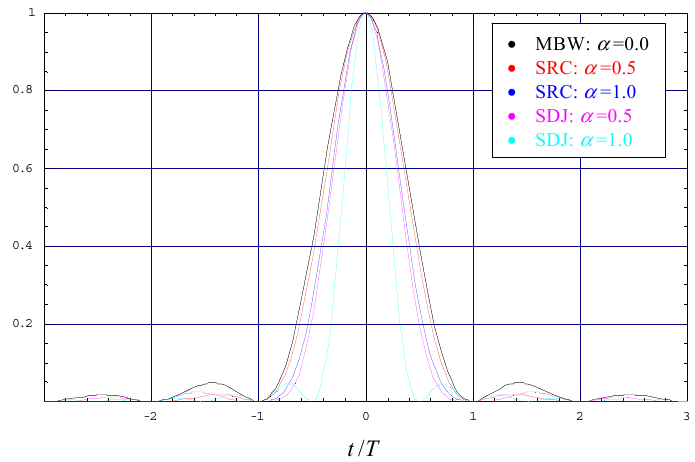
Figure 1. Evolution of different pulse shapes. MBW is minimum bandwidth, SRC is squared raised cosine, SDJ is squared double jump.